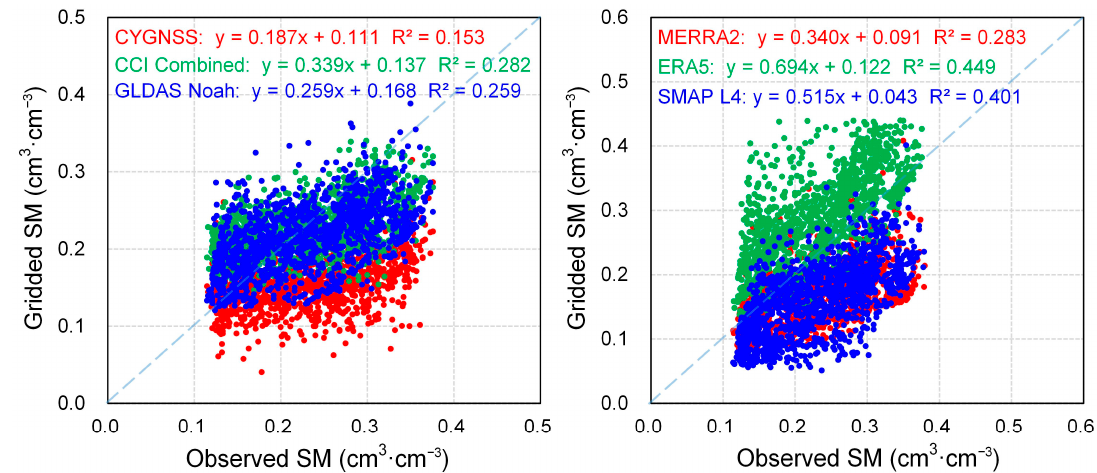
Figure 5. Scatterplot comparison of soil moisture products against in situ observations at a cropland station (station No. 2 in Figure 1).